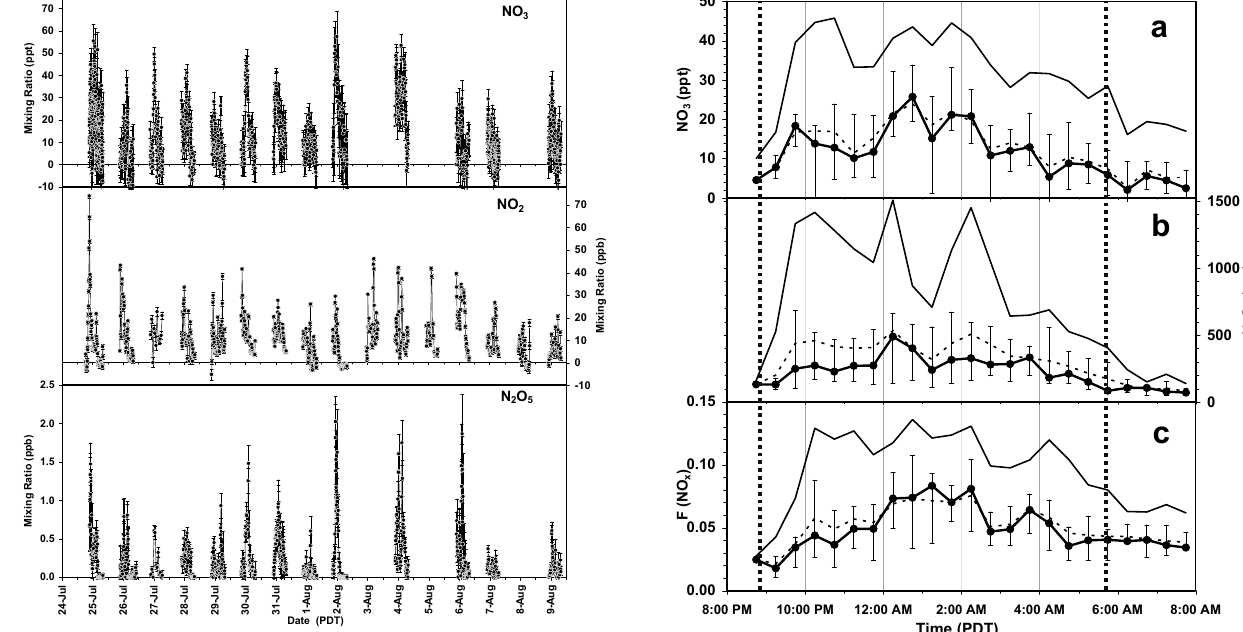
Fig. 4. Study average nocturnal variation in (a) NO 3 (b) N 2 O 5 and (c) F(NO x ) – partitioning of nitrogen in nighttime reservoir species (see Eq. 2) Shown are the average (dotted line), median (solid point), 95th (solid line), 75th (top whisker) and 25th per- centiles (bottom whisker) in each 30 min time